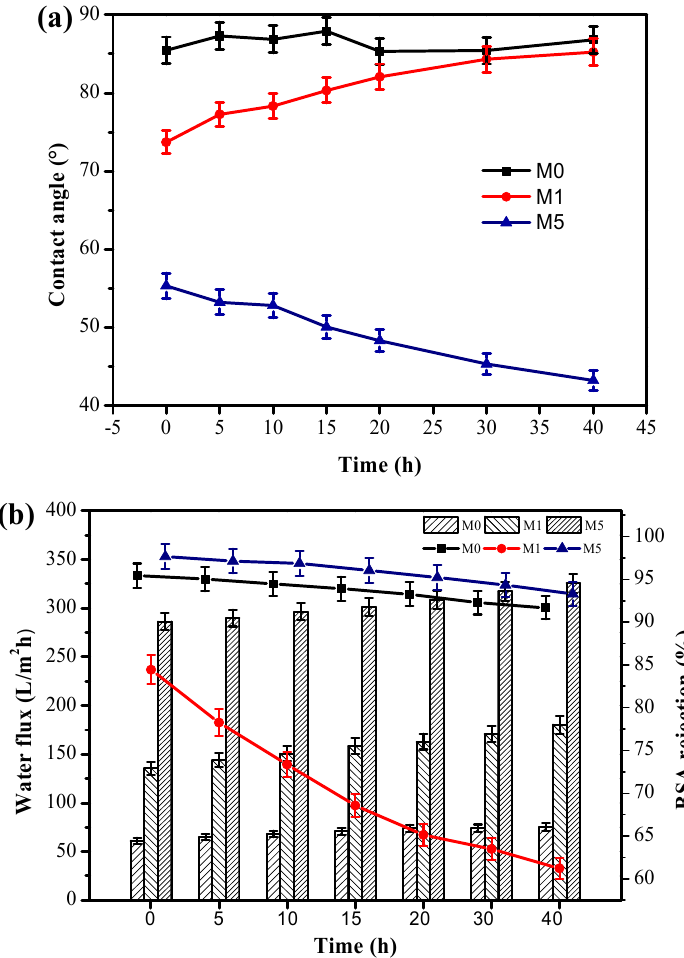
Figure 6. The effect of heat treatment (80 °C) on water contact angle ( a ), water flux (bar graphs) and BSA rejection (line graph) ( b ) in different incubation periods.